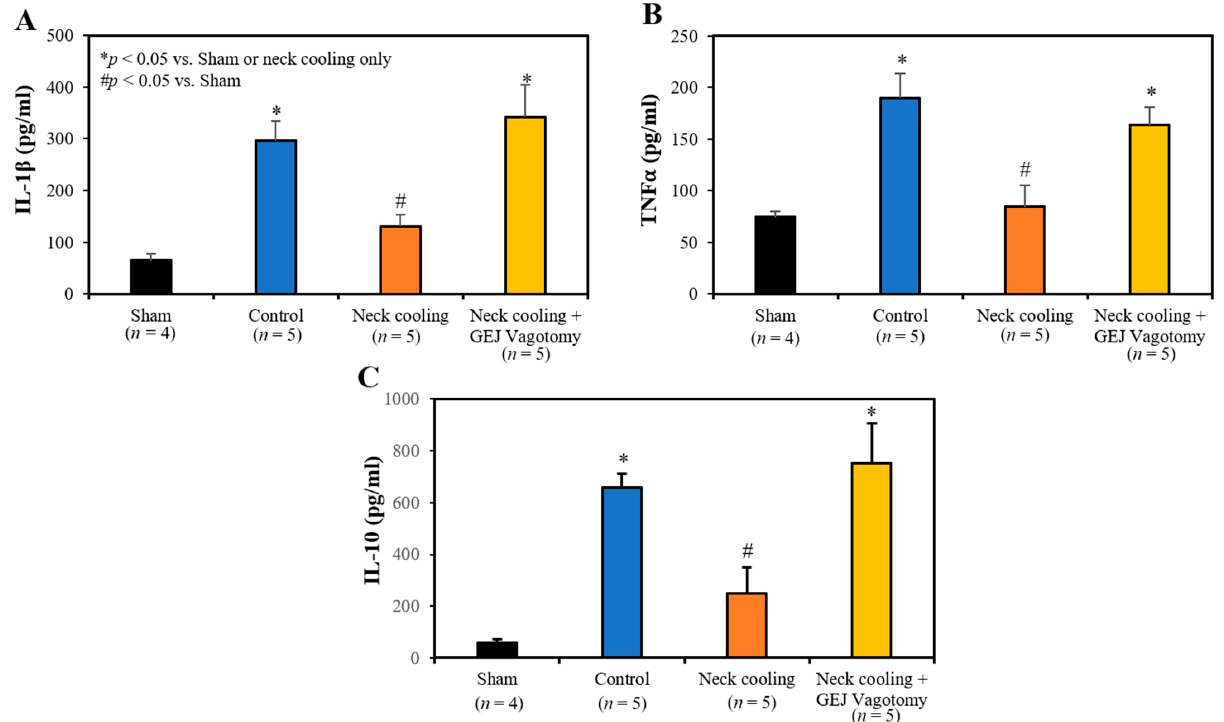
Figure 6. Plasma levels of ( A ) IL-1 β , ( B ) TNF ⍺ and ( C ) IL-10 at 3 hours after CLI.